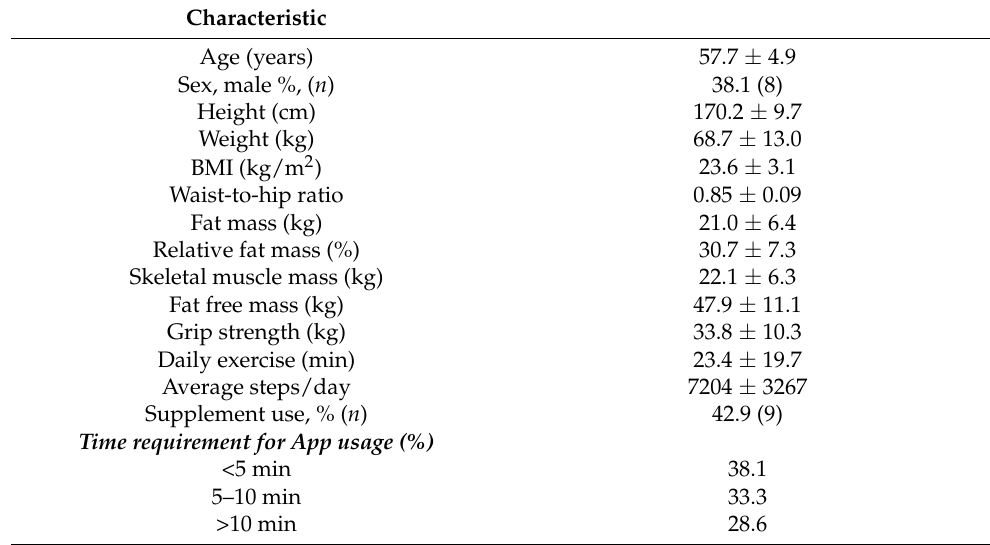
Table 1. Participant Baseline Characteristics ( n =